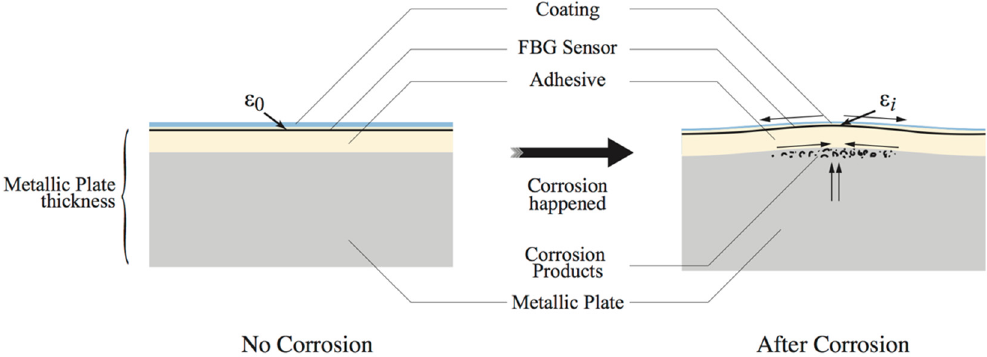
Figure 3. Cross ‐ section of corrosion monitoring system. Figure 3. Cross-section of corrosion monitoring